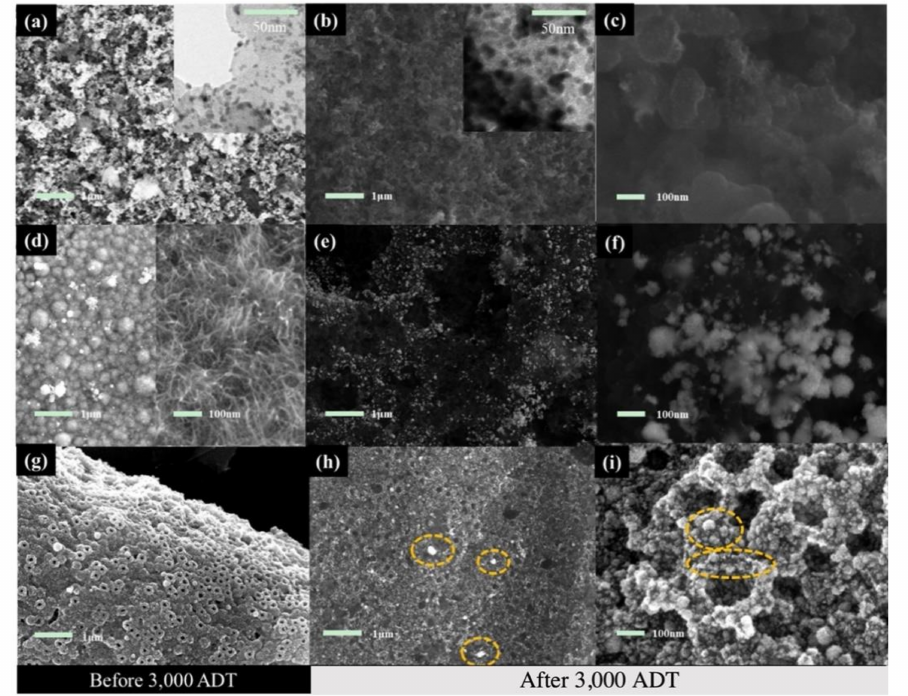
Figure 7. SEM and TEM images of Pt/C/GDL cathode ( a – c ), Pt nanowire/GDL cathode ( d – f ), and Pt-TiO 2 @C porous ordered cathode ( g – i ) before and after 3000 cycles of the